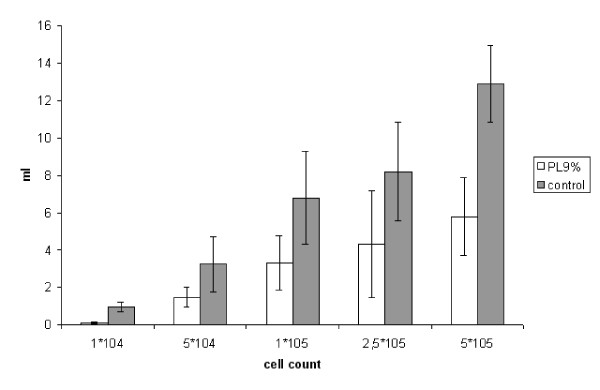
Experiment B: Volume of intraperitoneal tumor (ml, SEM). (1*104 p = 0,001; 5*104 p = 0,0007; 1*105 p = 0.007; 2,5*105 p = 0,0031; 5*105 p = 0,003)